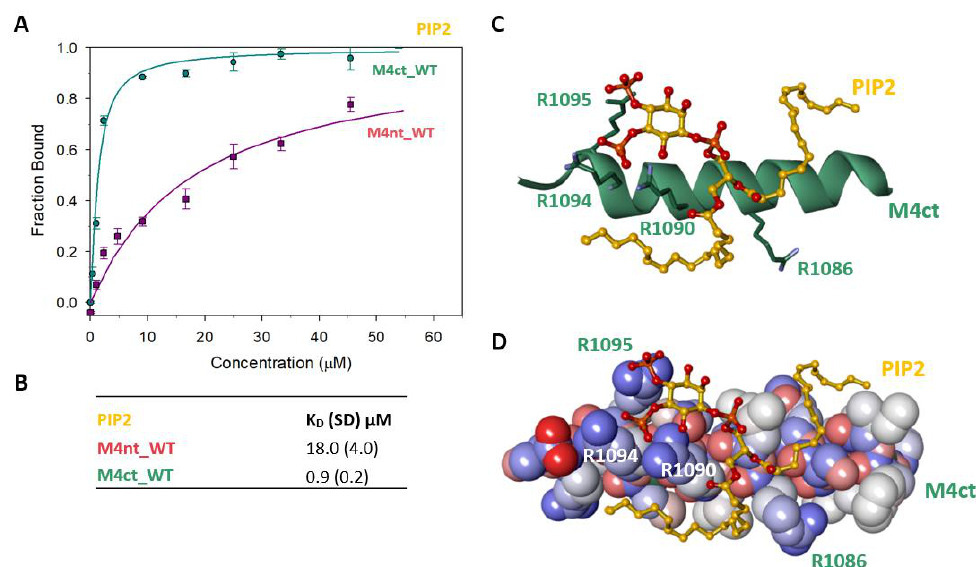
Figure 6. The M4nt / PIP 2 and M4ct / PIP2 complexes. ( A ) The F B of M4ct_WT (circles) and M4nt_WT (squares) as a function of PIP 2 (yellow) concentrations. The labelled PIP 2 was titrated by M4nt or M4ct peptides, and F B was calculated according to Equation (1); the solid lines represent the best fit to the binding isotherm from Equation (2) (Methods). ( B ) The equilibrium K D of PIP 2 in complexes with M4nt and M4ct peptides obtained by steady-state FA. ( C , D ) Spontaneous association of PIP 2 (ball and stick representation, yellow colour) and M4ct (sticks in green colour or CPK with a partial-charge representation) was observed within a 100-ns MD run. The salt bridges were formed between the phosphate groups of PIP 2 and R1090, R1094 and R1095 of M4ct (green colour, stick representation).